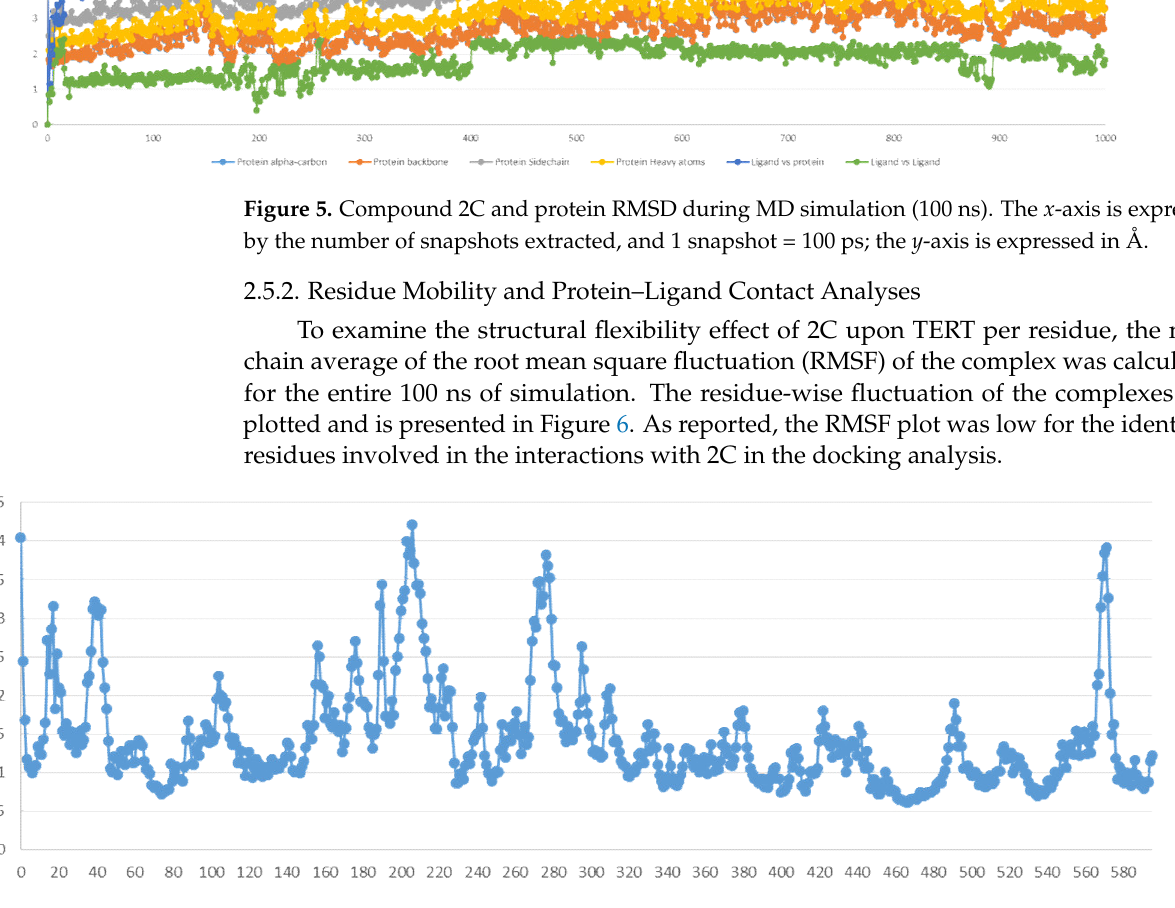
Figure 6. Protein RMSF during MD simulation (100 ns). The x -axis reports the number of the resi- dues of TERT, and the y -axis is expressed in Å.